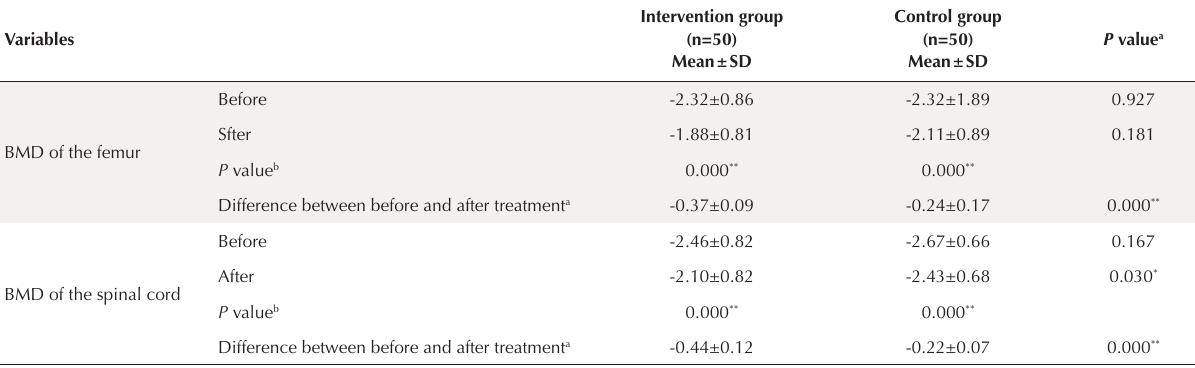
Table 1. Comparison of bone densitometry results in intervention and control groups